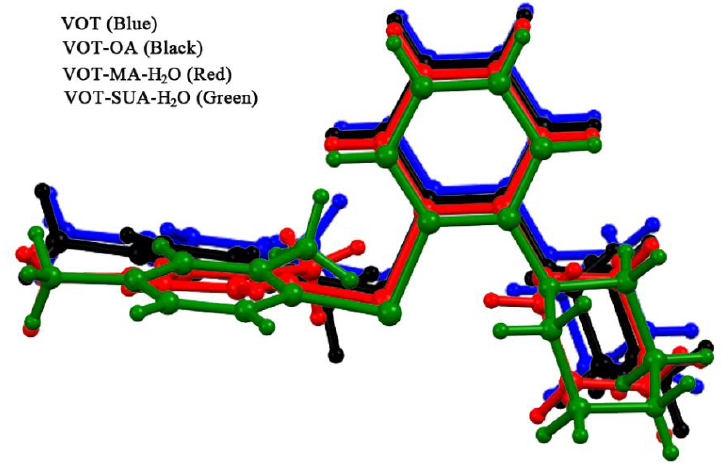
Figure 5. Overlay of VOT molecules extracted from crystal structures. Color codes: blue = VOT; black = VOT-OA (1:1); red = VOT-MA-H 2 O (1:1:1); green = VOT-SUA-H2O (1:1:0.5).